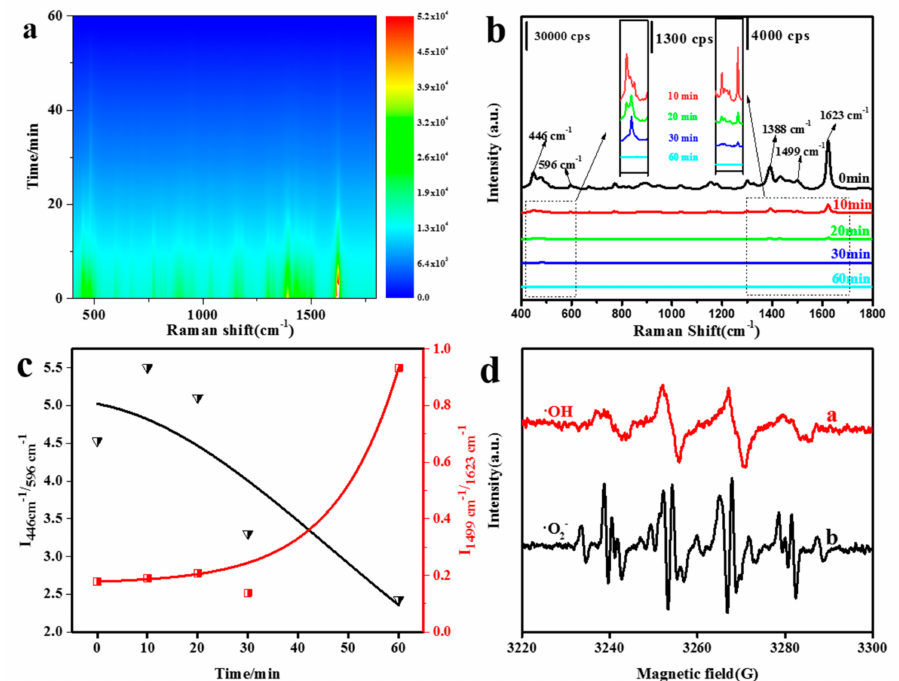
Figure 3. Time-dependent SERS mapping of catalytic degradation of MB by MoS 2 /Au heterojunctions ( a ); SERS spectra of catalytic degradation of MB by MoS 2 /Au heterojunctions ( b ); The relative intensities of SERS bands at 446 to 549 cm − 1 and 1499 to 1623 cm − 1 as a function of reaction time ( c ); ESR spectra of · OH and · O 2 − in the catalytic degradation of MB by MoS 2 /Au using DMPO as the spin-trapper ( d